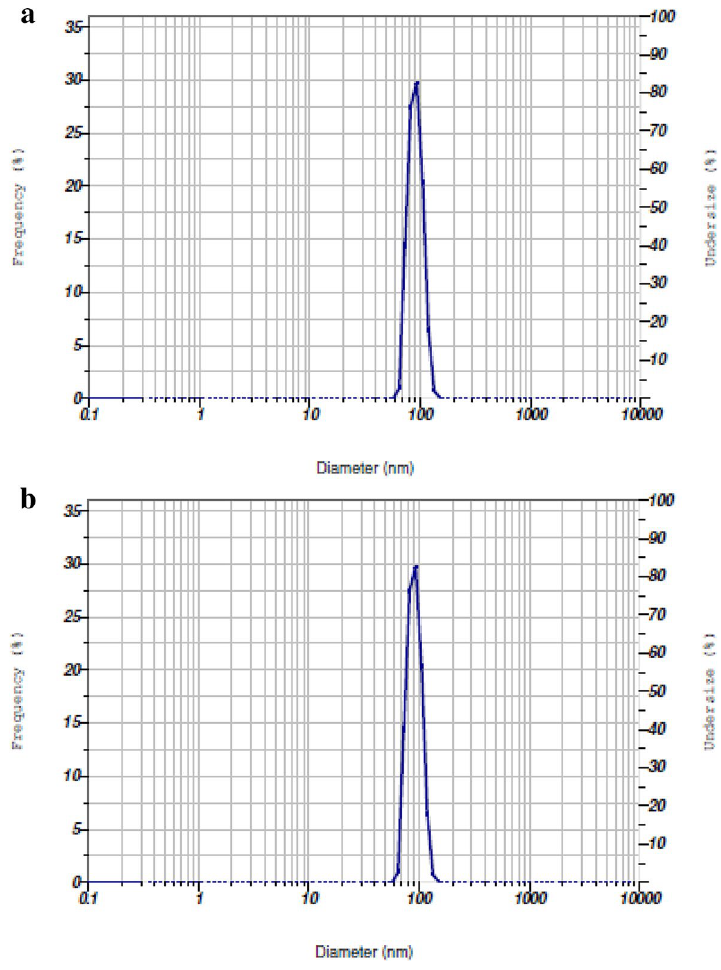
Figure 3. ( a ) Particle size of nano zeolite before loading Zn. ( b ) Particle size of nano zeolite after loading